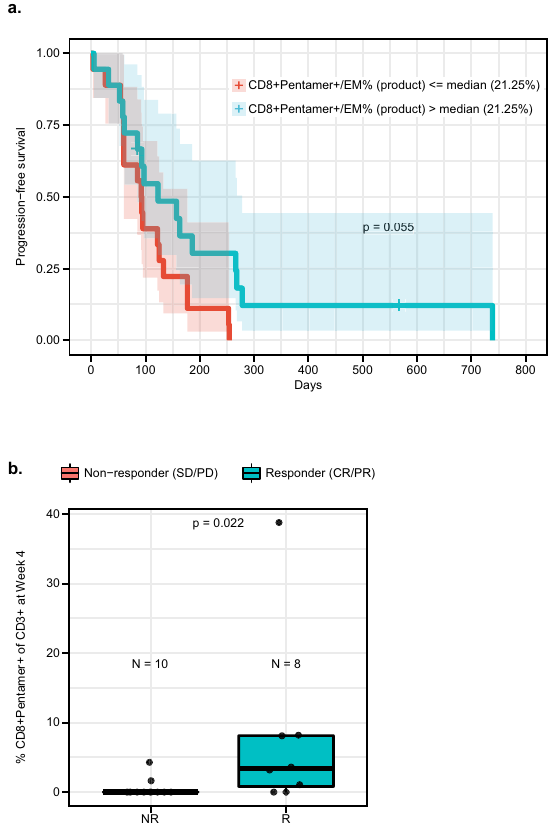
individual data points. Lower whisker is the minimum value of the data within 1.5 times the interquartile range below the 25th percentile. Upper whisker is the maximum value of the data within 1.5 times the interquartile range above the 75th percentile.Nominaltwo-sided p -valuesbasedontheWilcoxonranksumtestorlog- rank test for PFS are presented and correlations are based on Spearman method. CMcentralmemory(CD45RA-CCR7+),CRcompleteresponse,EMeffectormemory (CD45RA-CCR7-), Naïve (CD45RA+CCR7+), PFS progression-free survival, PD pro- gressivedisease,PRpartialresponse,SDstabledisease,TEMRATeffector